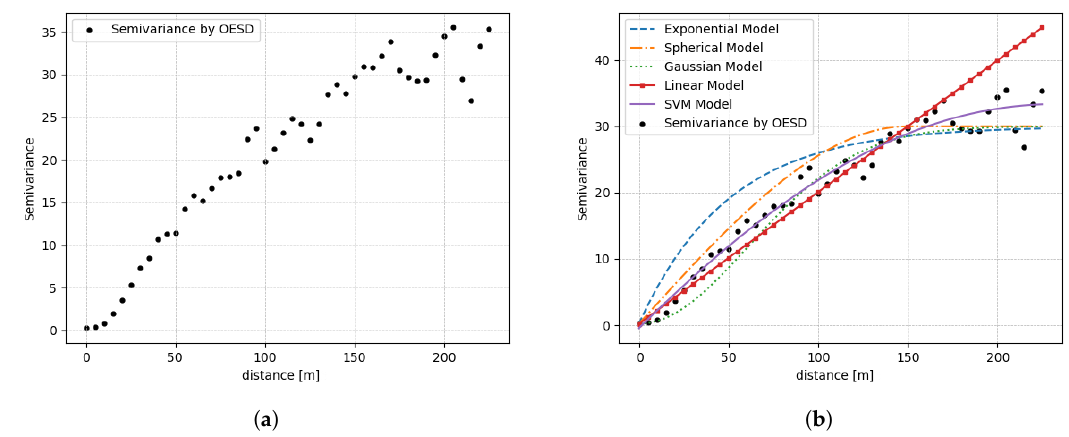
Figure 12. ( a ) Semivariance trends calculated by OESD. ( b ) Various trends of the fitted variogram model.